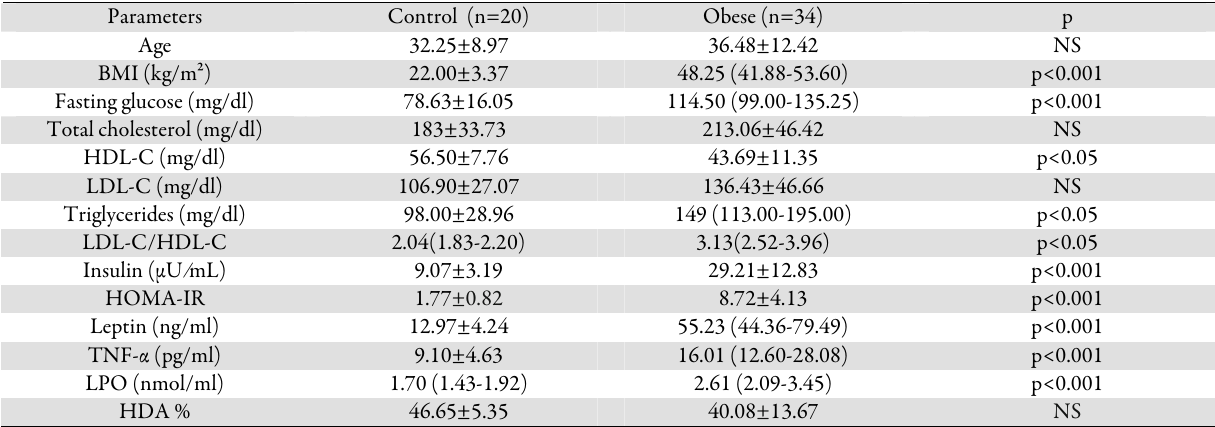
Tab. 1. Anthropometric and laboratory characteristics of the groups